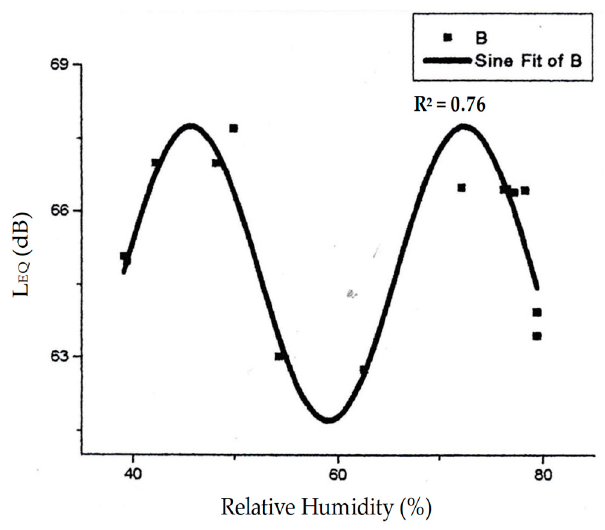
Buildings 2018 , 8 , x FOR PEER REVIEW Figure 12. Correlation modeling between Relative Humidity and Noise Level at OW-L.